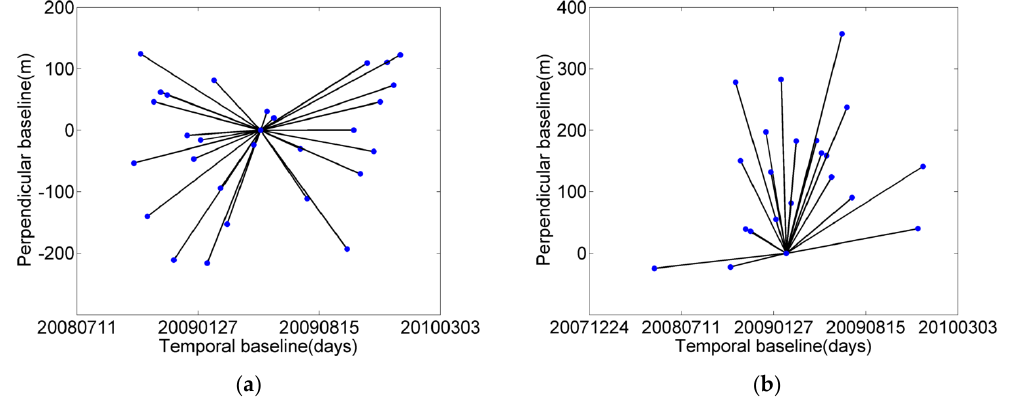
Figure 3. Temporal/perpendicular baseline plots. ( a ) TerraSAR-X Spotlight images for HKIA and ( b ) TerraSAR-X Stripmap images for HKSP.